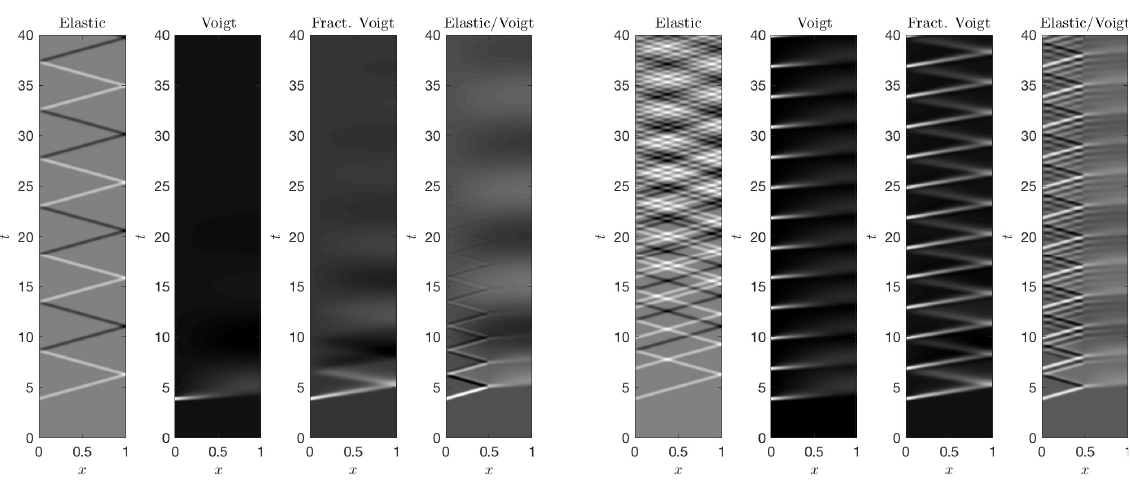
Fig. 8 Space-time plots with parameters described in Table 5 where first and last four subplots correspond to the signals shown on the left and right of Figure